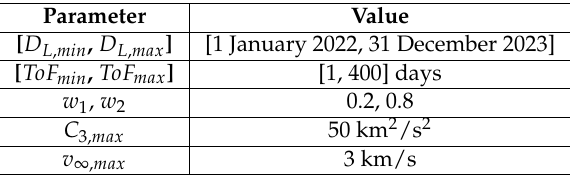
Table 4. Parameters and bounds supplied as inputs to the heliocentric cruise design